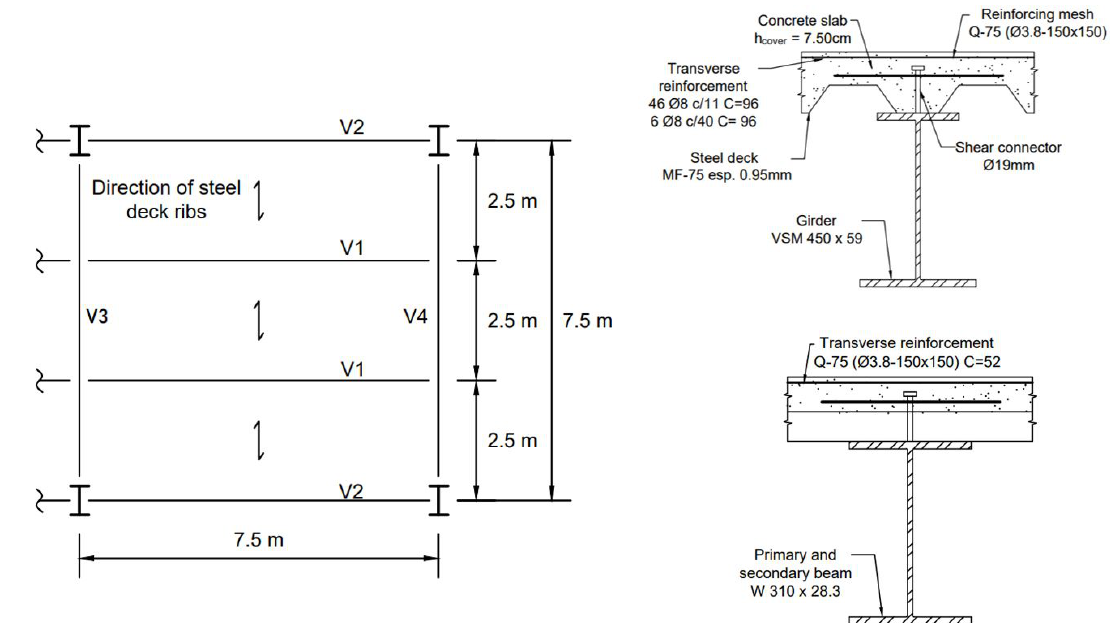
Figure 3. Geometry of the floor system from example